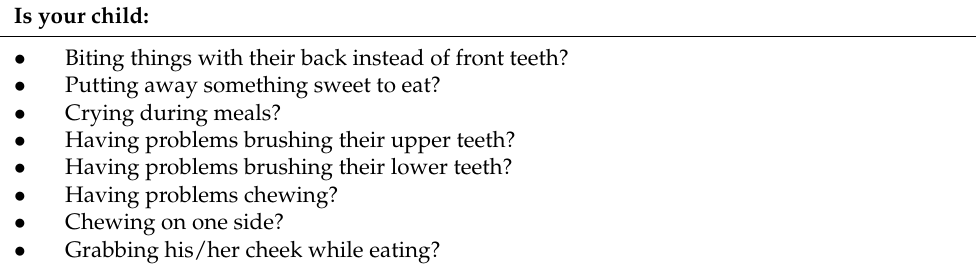
Table 1. The dental discomfort questionnaire (ddq-8).